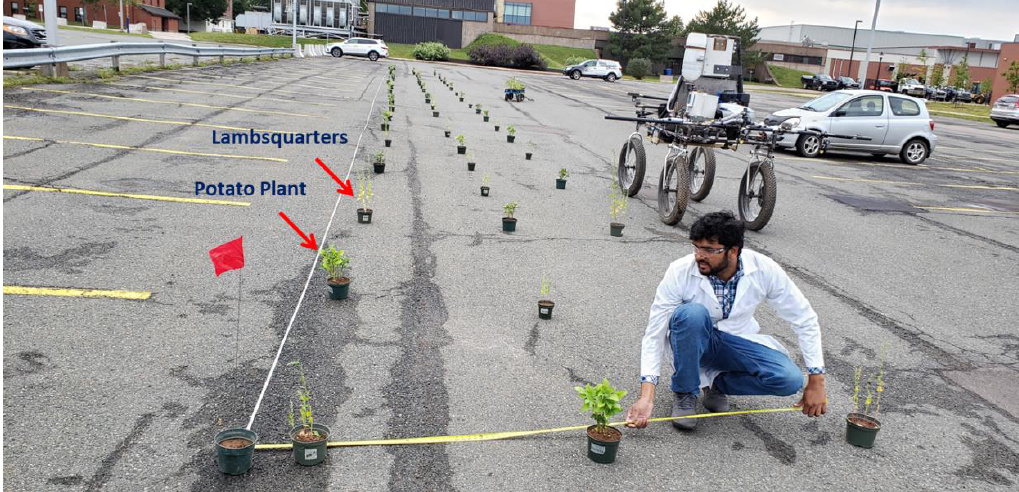
Figure 6. Design of the laboratory experiment for testing of smart variable rate sprayer. The experimental setup consisted of 60 m long and 2.74 m wide strips of randomly arranged healthy, simulated diseased, and weed plants.